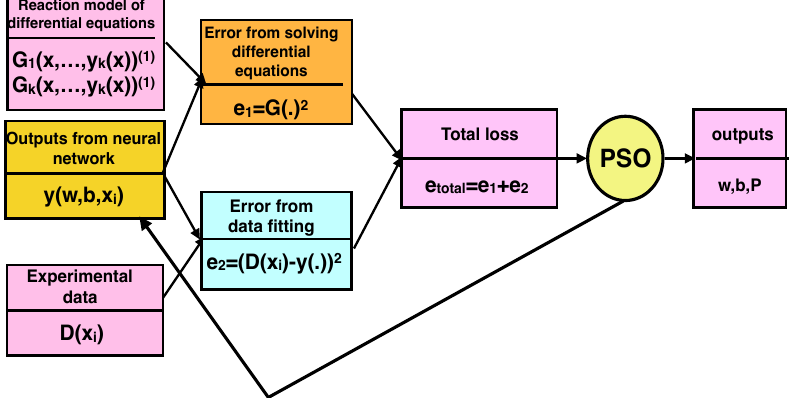
Figure 2. A flow chart depicting the the main steps and calculation mechanism of AKPE. The mud- colored box represents outputs from neural networks, which are adjusted according to the results produced by PSO, the outputs of PSO are parameters from neural networks w , b , and coefficients from the reaction-derived differential